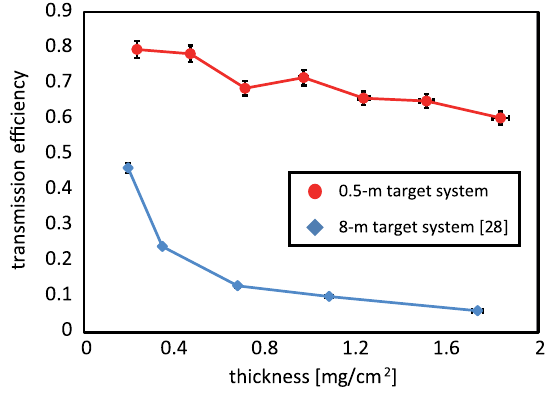
FIG. 5. Transmission efficiency of a selected charge state as a function of the helium thickness. The most probable charge state for each thickness was selected and transported for the measurements.